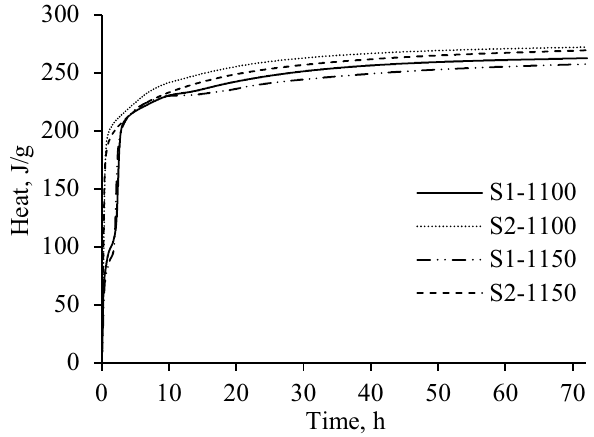
Figure 5. Curves of the cumulative heat of eco-friendly cement samples.